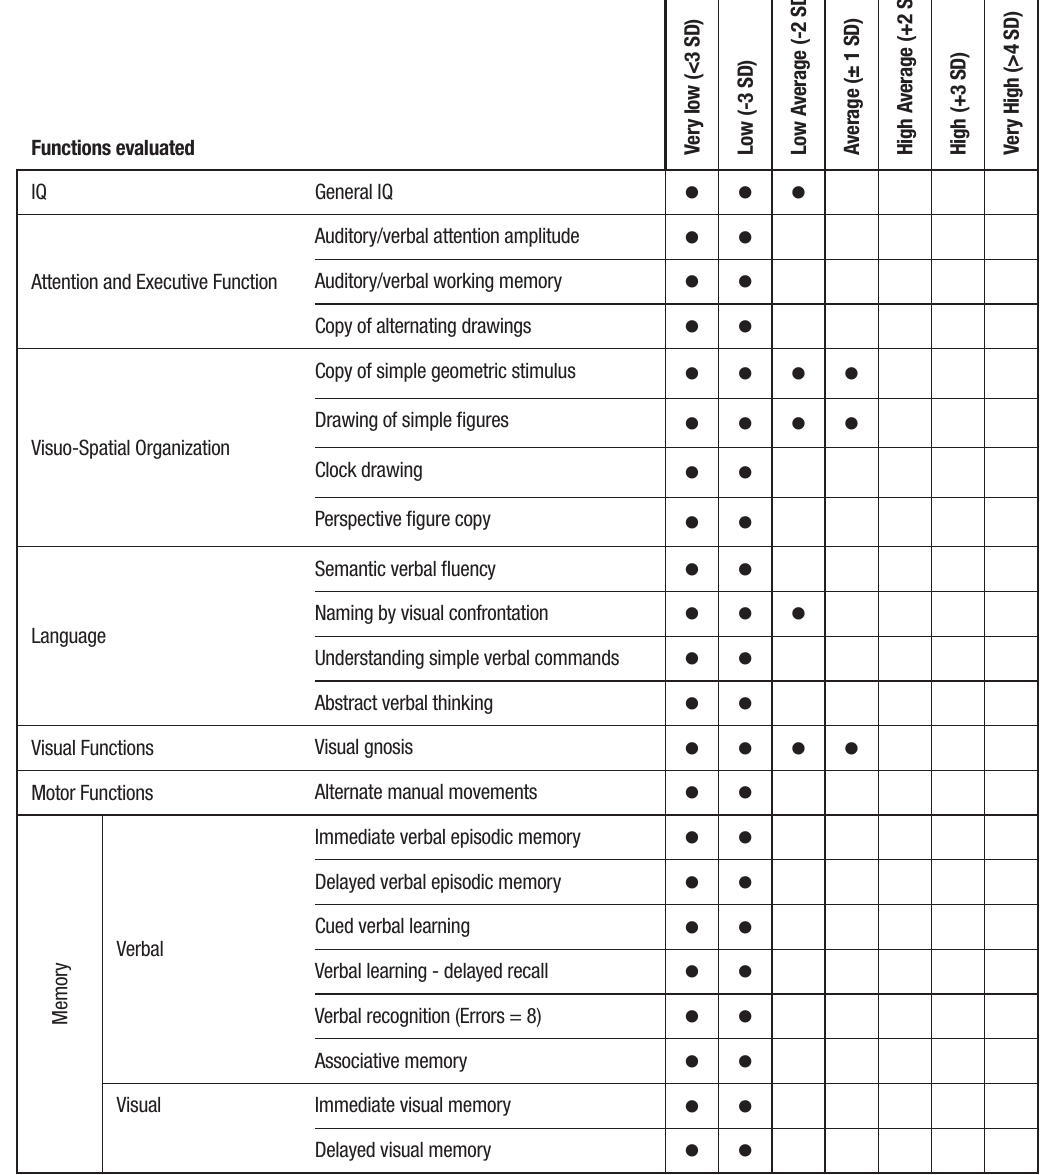
Table 1. Neuropsychological test